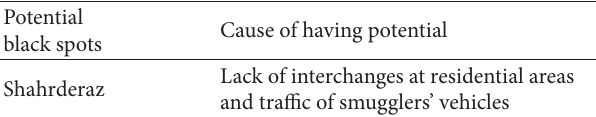
Table 3: Section 3: Kalaat-Sarbaaz.